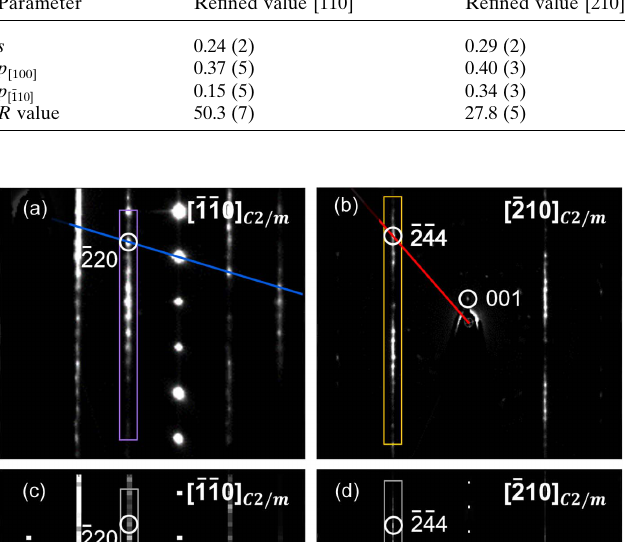
Table 1 Refined short-range order parameters and the R value at generation 50 for the intensity profile of the diffuse streaks indicated in the [110] and [210] reciprocal space sections of crystal 1. s is the stacking fault probability, and p [100] and p ½ (cid:2) [100] and [110] twins in the